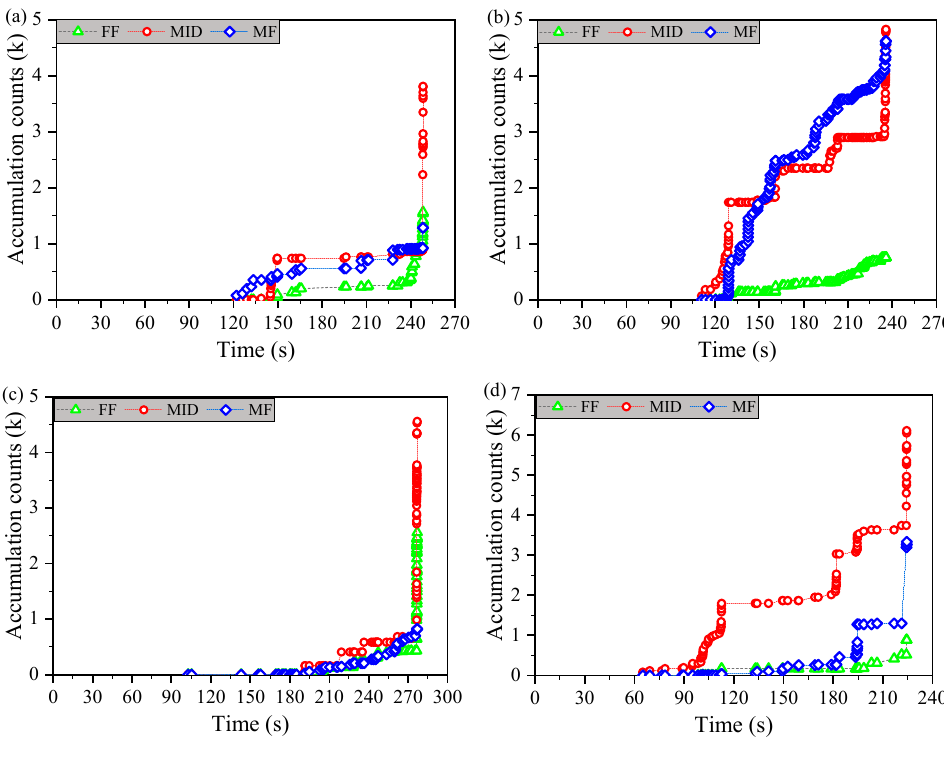
Figure 8. Acoustic emission damage mode of the accumulation counts–time relationship graphs: ( a ) Group A, ( b ) Group B, ( c ) Group C, and ( d ) Group D.